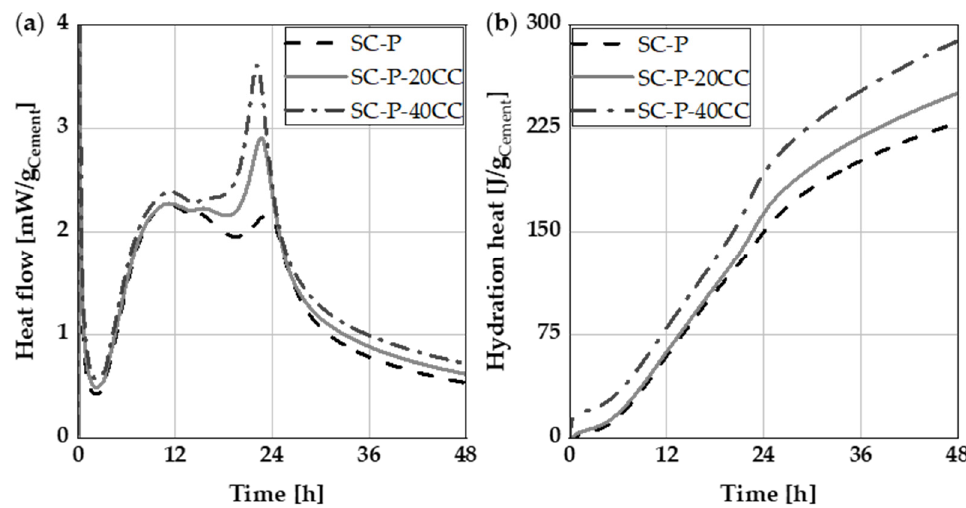
Figure 8. Heat flow ( a ) and Hydration heat ( b ) of SC-P with and without CC.